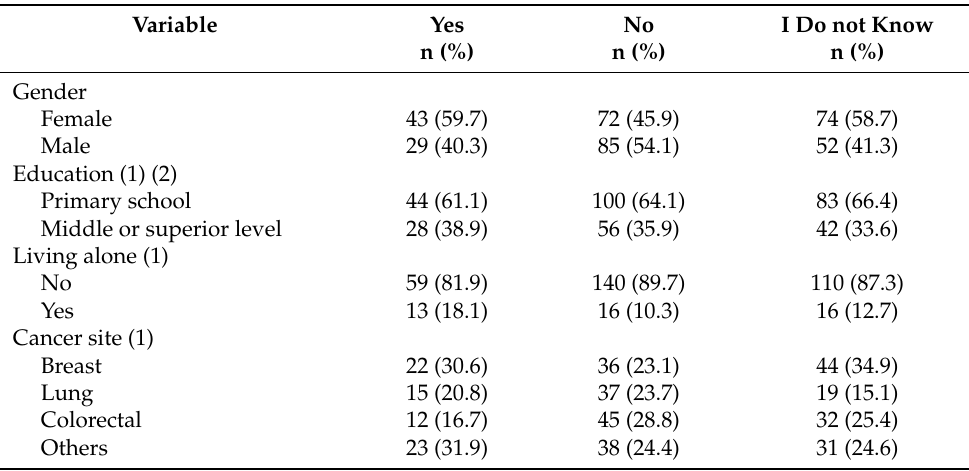
Table 1. Psychosocial profile of participants who answered “Yes” (n = 72), “No” (n = 157) or “I do not know” (n = 126) to the question: “Do you want to receive psychological